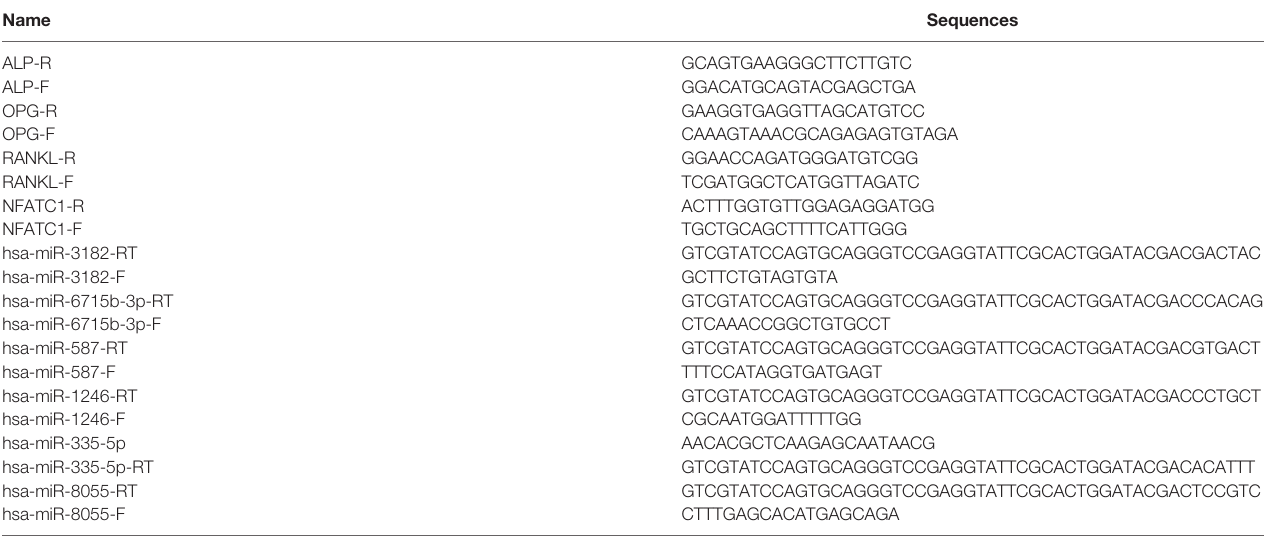
TABLE 1 | The sequences of the